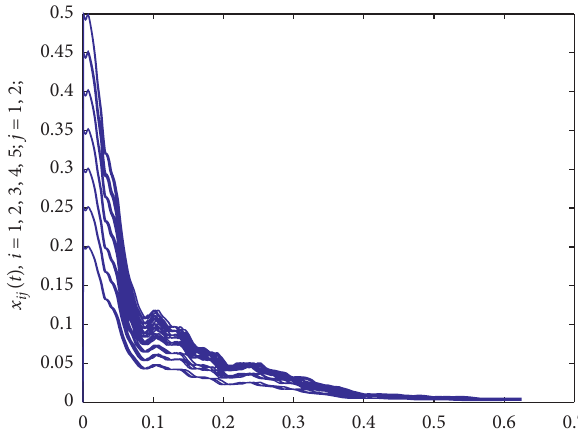
Figure 1: The synchronization of each node x